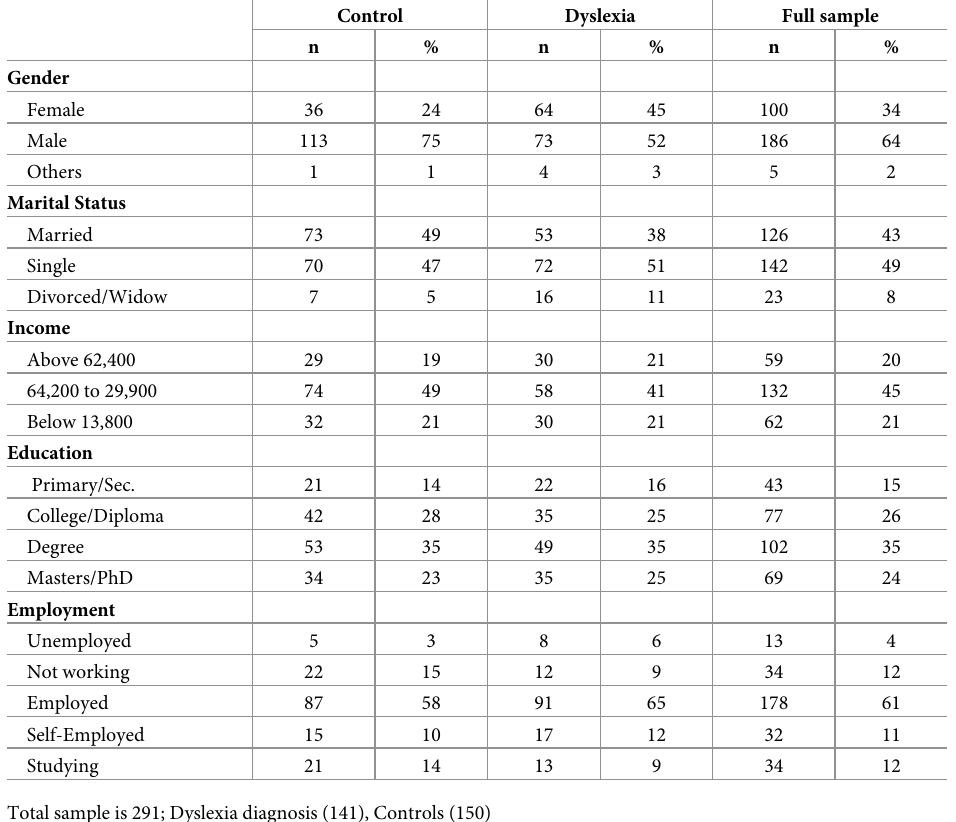
Table 1. Sociodemographic characteristics of